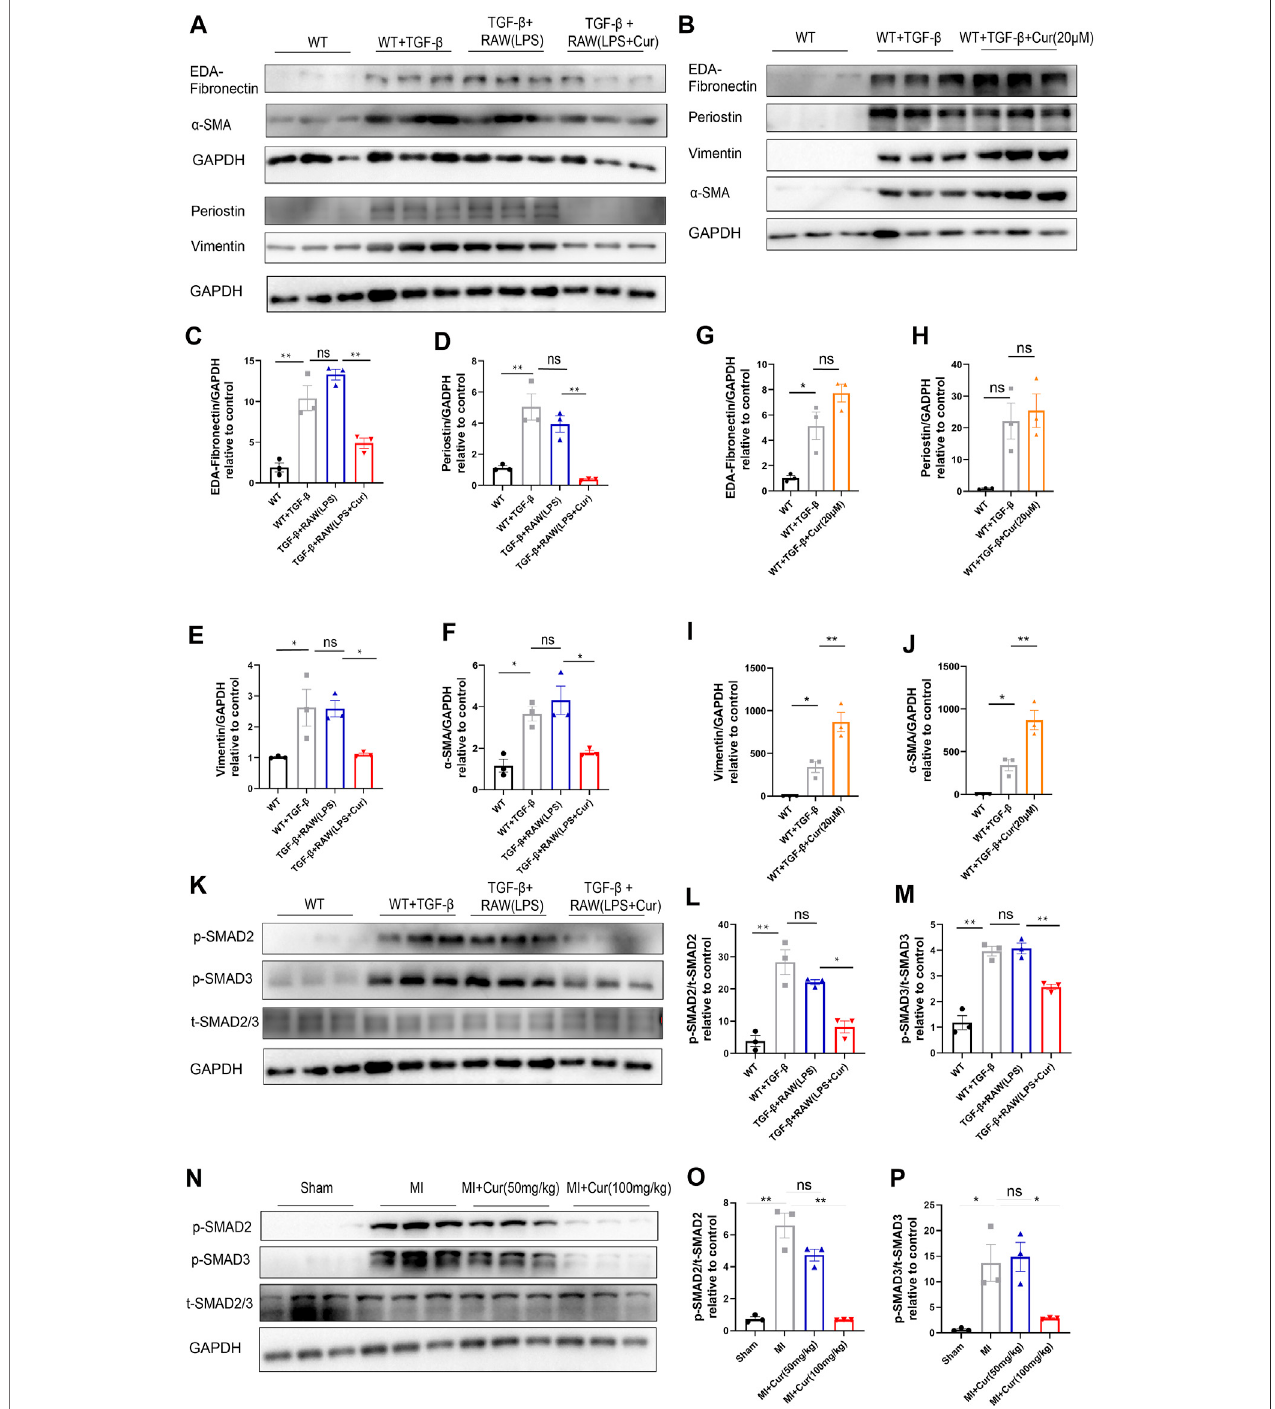
FIGURE 4 | Curcumin inhibits cardiac fi brosis by regulating macrophage- fi broblast crosstalk instead of directly suppressing cardiac fi broblast trans -differentiation (A). Fibrotic protein expression in different NRCF group (WT, WT + TGF- β , TGF- β +RAW (LPS), TGF- β +RAW (LPS + Cur)) respectively, fi brotic protein is de fi ned as EDA-Fibronectin, periostin, vimentin and α -SMA (B). Fibrotic protein expression in different NRCF group (WT, WT + TGF- β , WT + TGF- β +Cur) respectively (C-F). Summary data of protein expression are displayed in (A) , EDA- fi bronectin are plotted in (C) , periostin is plotted in (D) , vimentin is plotted in (E) and α -SMA is plotted in (F) (G – J) . Summary data of protein expression displayed in (B) , EDA-Fibronectin was plotted in (G), periostin was plotted in (H) , vimentin is plotted in (I) and α -SMA in J) (K – M). TGF- β R1 downs-stream signalingidenti fi cationbywesternblotineachgroup(WT,WT+TGF- β ,TGF- β +RAW(LPS),TGF- β